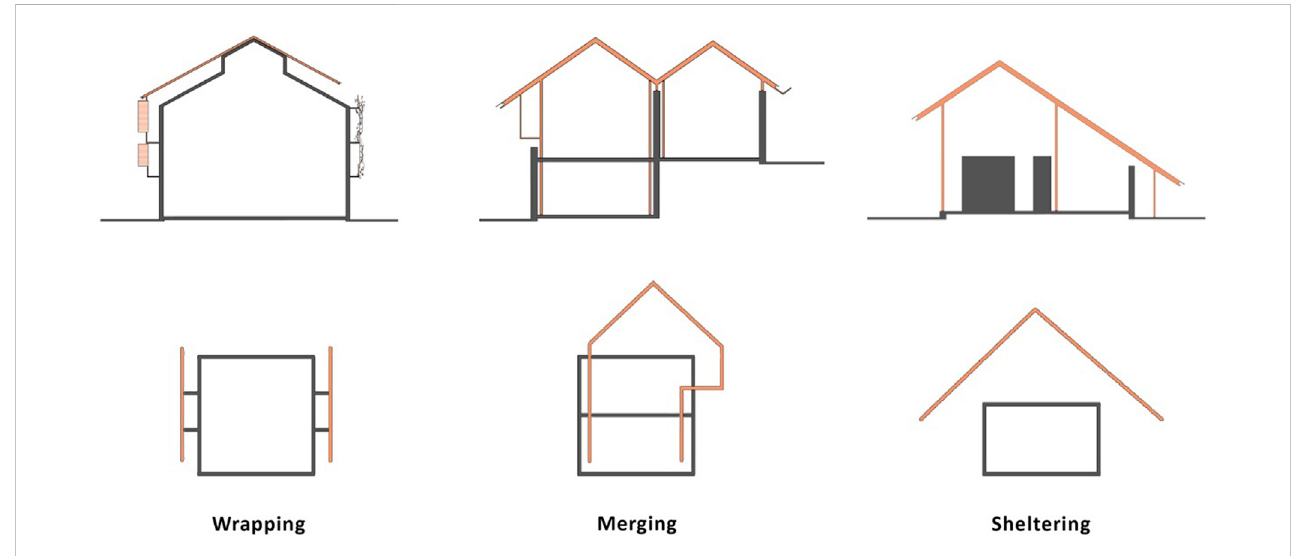
FIGURE 6 Typologies of reuse: wrapping, merging and